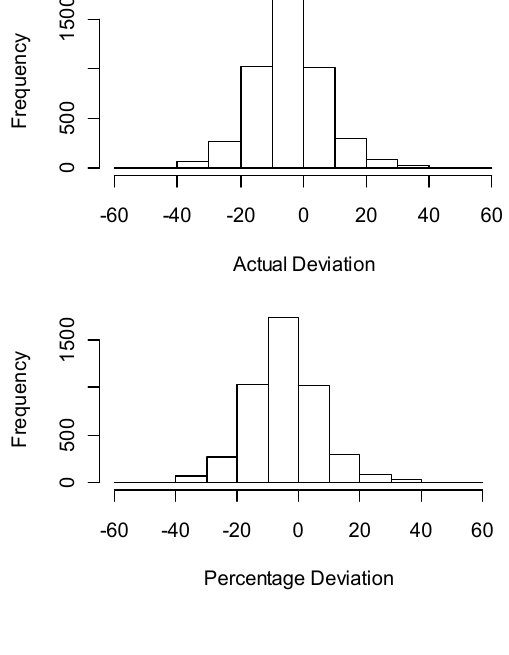
<Figure 1> Empirical Distribution of Deviations